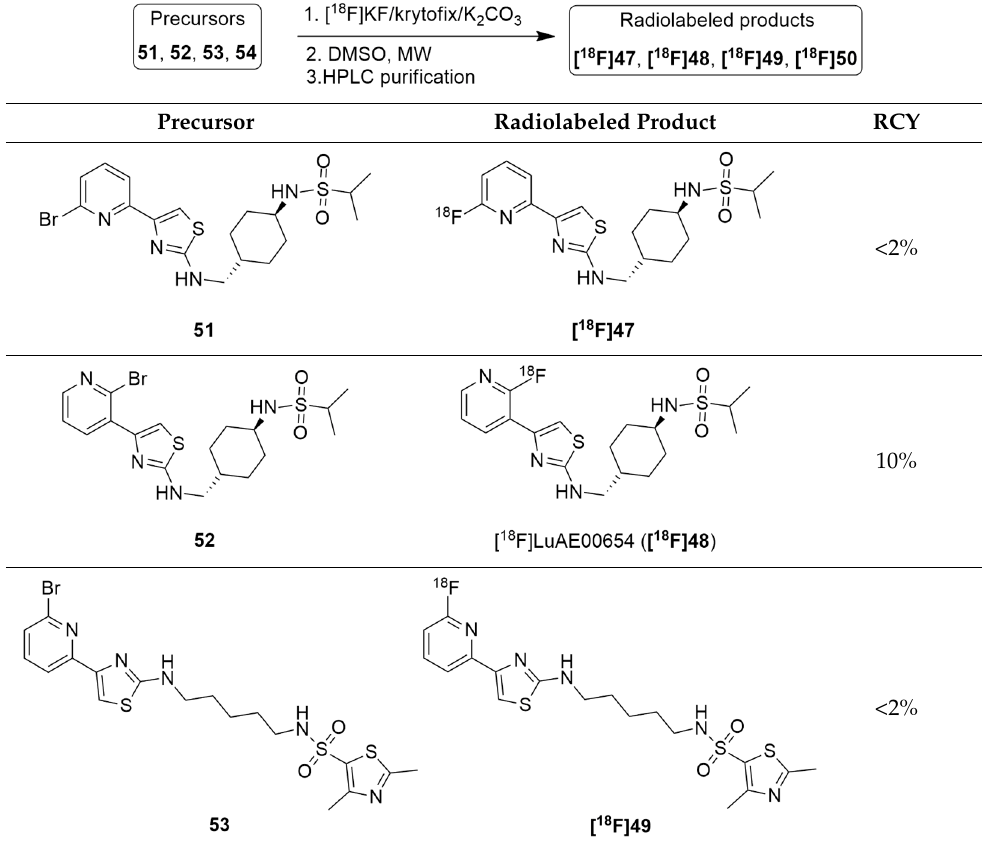
Table 6. Radiosynthesis of NPY Y5 ligands under microwave irradiation. Table 6 . Radiosynthesis of NPY Y5 ligands under microwave irradiation. Table 6 . Radiosynthesis of NPY Y5 ligands under microwave irradiation. Table 6 . Radiosynthesis of NPY Y5 ligands under microwave irradiation. Table 6 . Radiosynthesis of NPY Y5 ligands under microwave irradiation. Table 6 . Radiosynthesis of NPY Y5 ligands under microwave irradiation. Table 6 . Radiosynthesis of NPY Y5 ligands under microwave irradiation. Table 6 . Radiosynthesis of NPY Y5 ligands under microwave